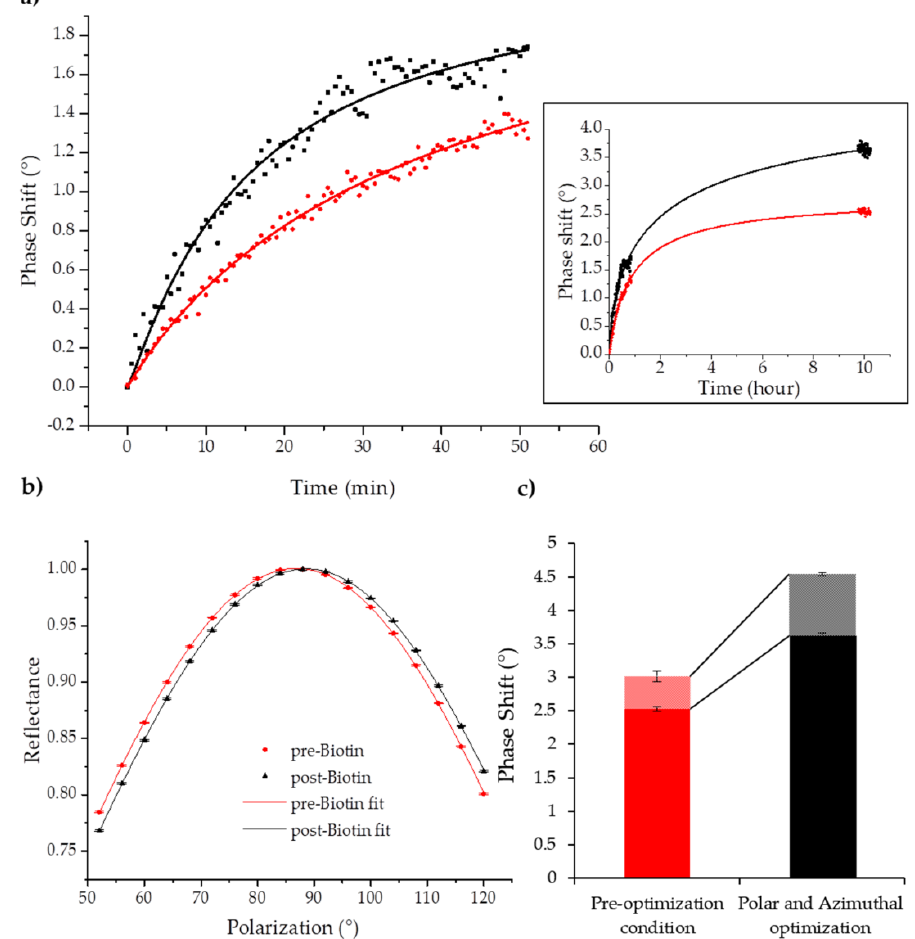
Figure 5. GC-SPR biosensing enhancement upon polar and azimuthal angles optimization. Biotin-PEG-SH functionalization shows higher phase shift in respect to “pre-optimization” configuration (in red) for “post-optimization” configuration (in black) in the first hour of the experiment ( a ) and after several hours when the functionalization is almost complete (inset). Data (square dots) were fitted with Hill curves (lines) obtaining values of the reduced R 2 > 0.999. ( b ) Representative curves of the polar spectrum at t = 0 and t = 10 h of Biotin functionalization. ( c ) Quantification of complete experimental results in terms of phase shift for the non-optimized (in red) and optimized (in black) configurations. Full colour bars quantify the phase shift due to Biotin-PEG-SH functionalization signal, while patterned bars quantify the subsequent Avidin binding to Biotin. Data are reported with s.e.m.